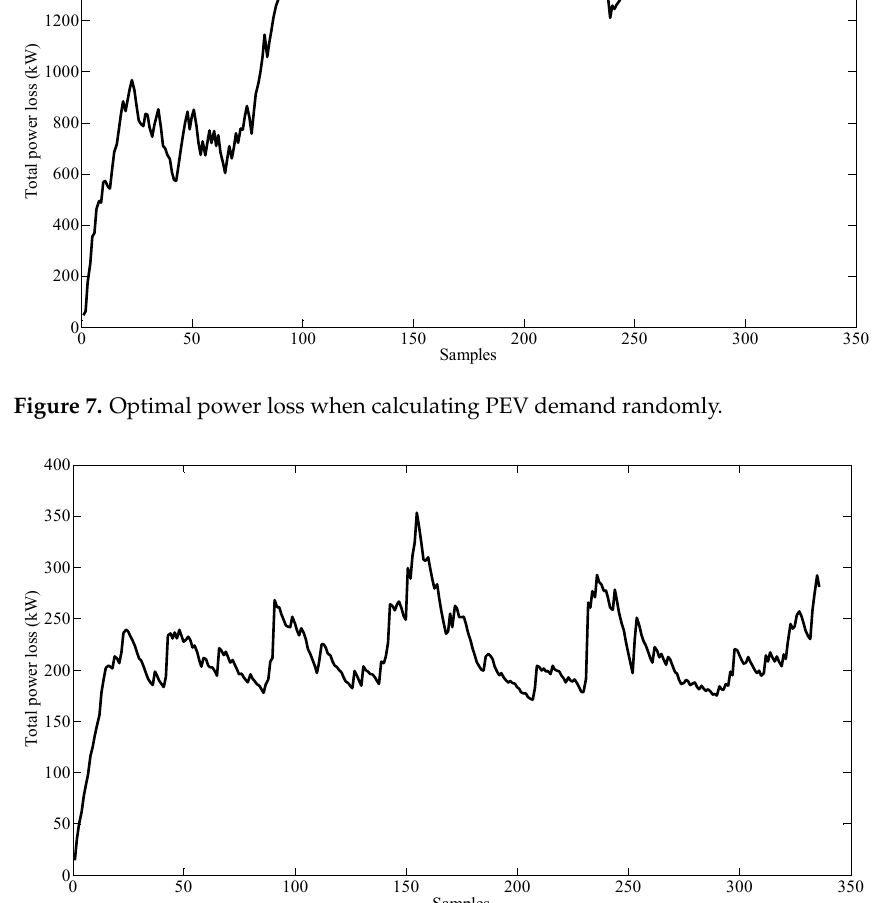
Figure 8. Optimal power loss when calculating PEV demand by minimum queuing parameters.